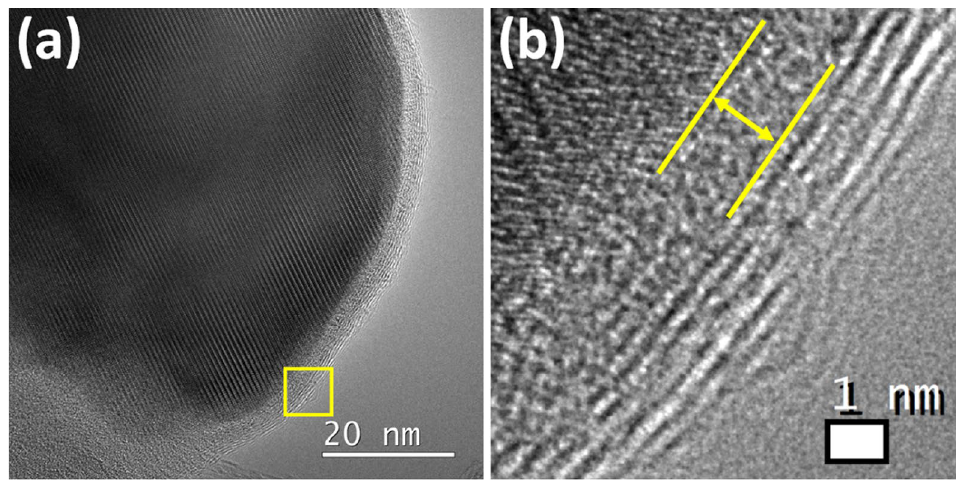
Figure 4. ( a ) The HRTEM image of the catalyst particle ( b ) the partial enlarged image of the selected area marked by the yellow rectangle in ( a ), showing an amorphous layer (SiO 2 ) and a multilayered structure (graphene).